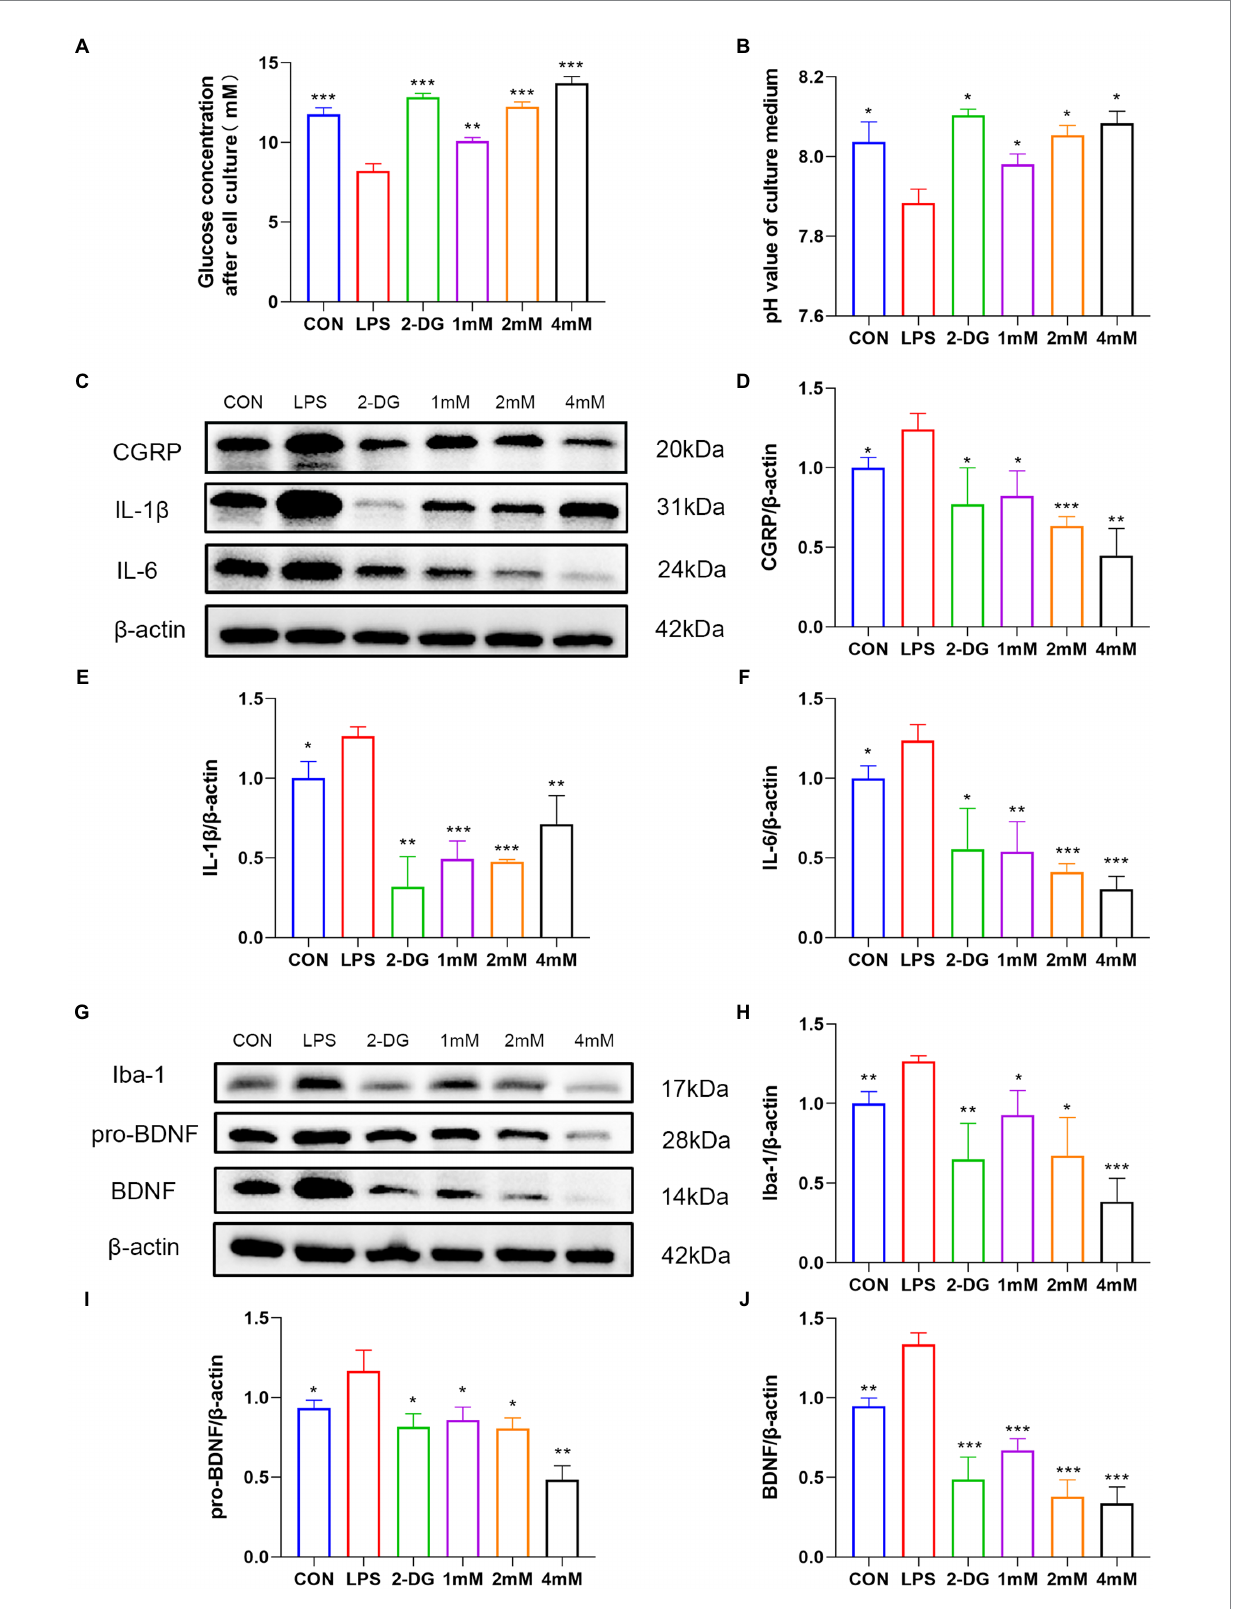
FIGURE 7 2-DG treatment can inhibit the activation of microglia and the release of pain-related molecules. Residual glucose (A) and pH (B) of culture supernatants after 12 h stimulation of BV2 by LPS with or without different concentrations of 2-DG. Data were expressed as mean ± SD ( n = 3 per